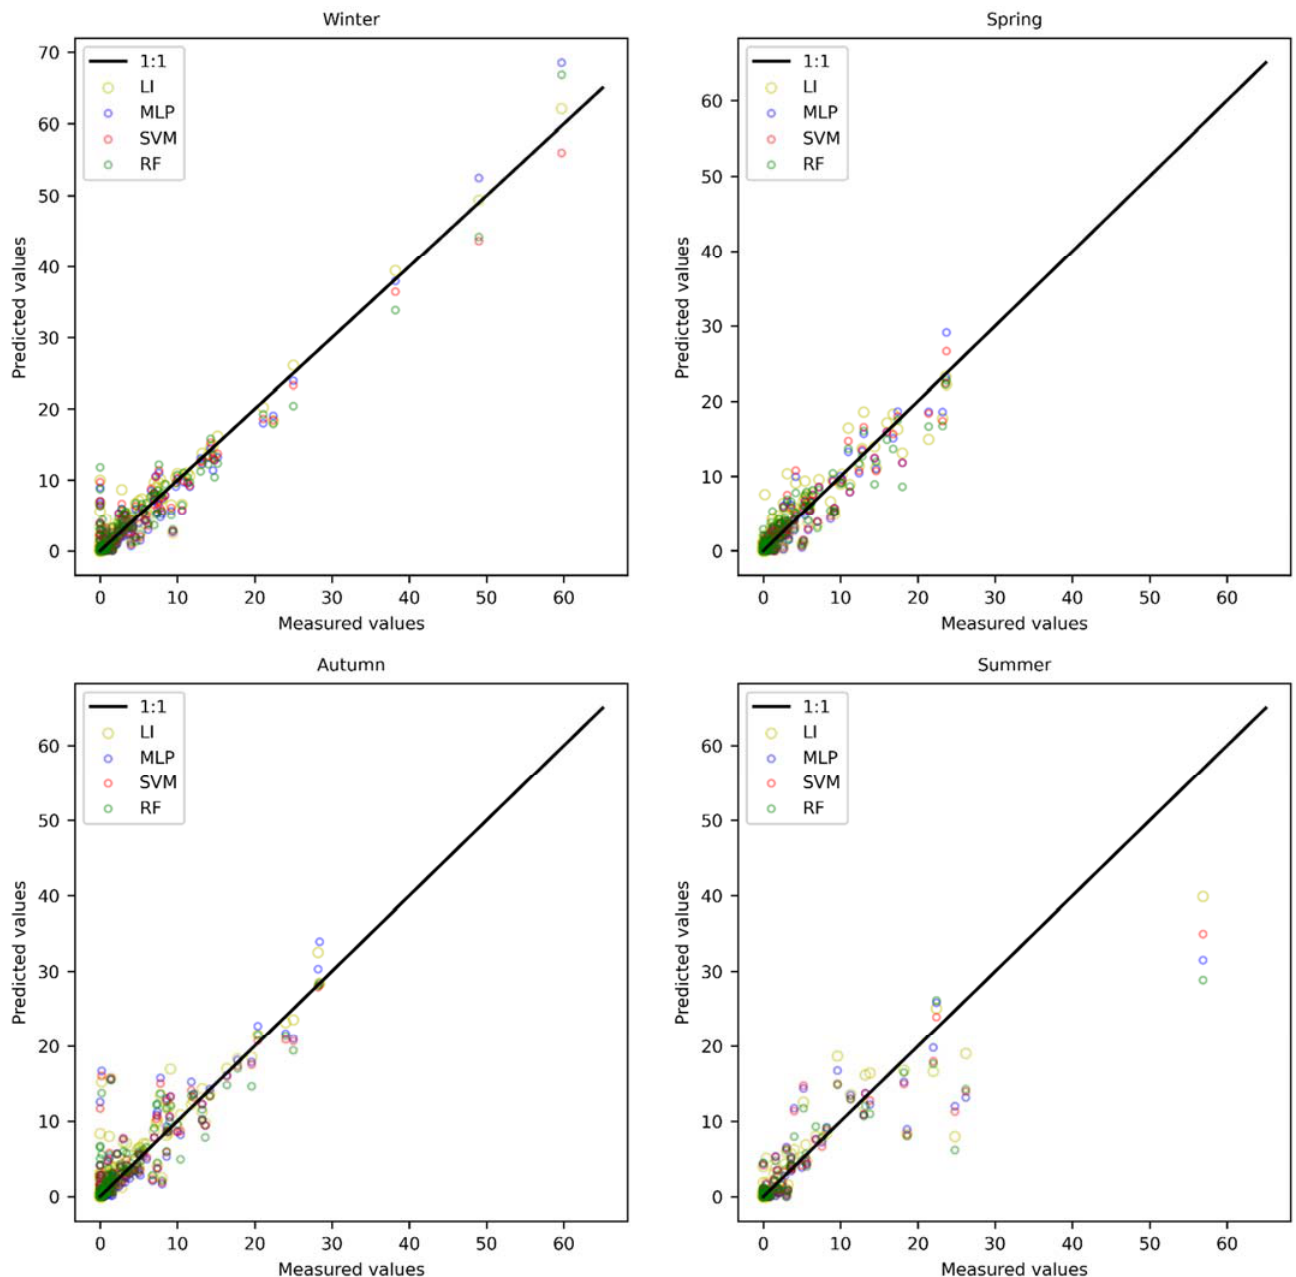
Figure 9. Scatter plot for predicted values in Torreblascopedro, using MLP, SVM, RF, and LI, during the different seasons.